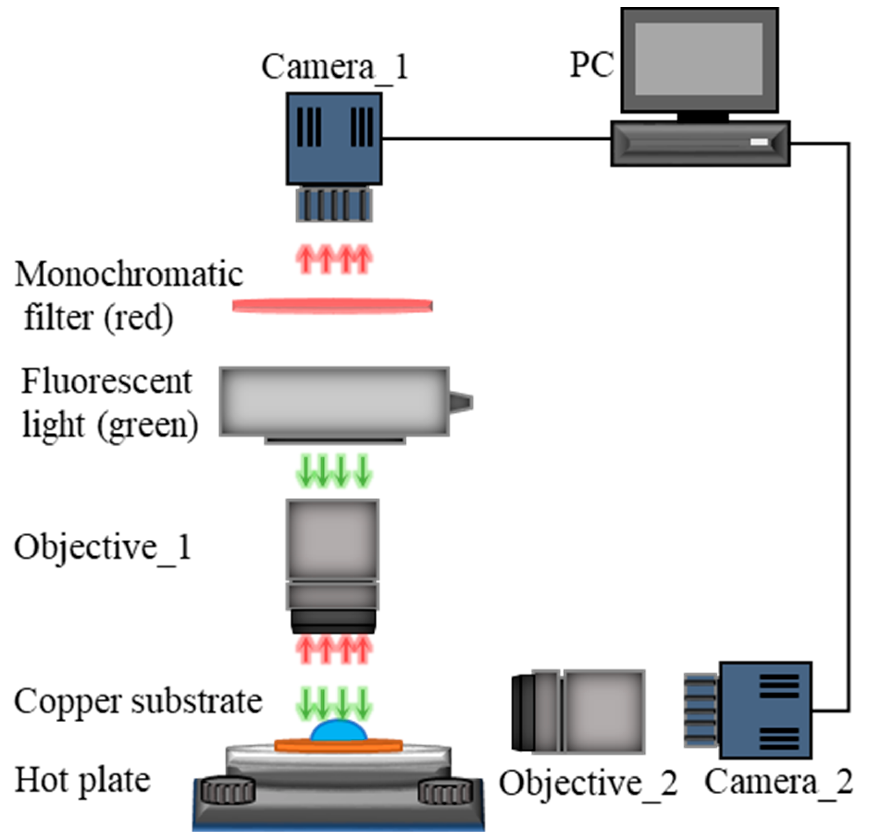
Figure 1. Schematics of the experiment setup used to probe the temperature profile at the liquid-gas interface of an evaporating sessile drop .